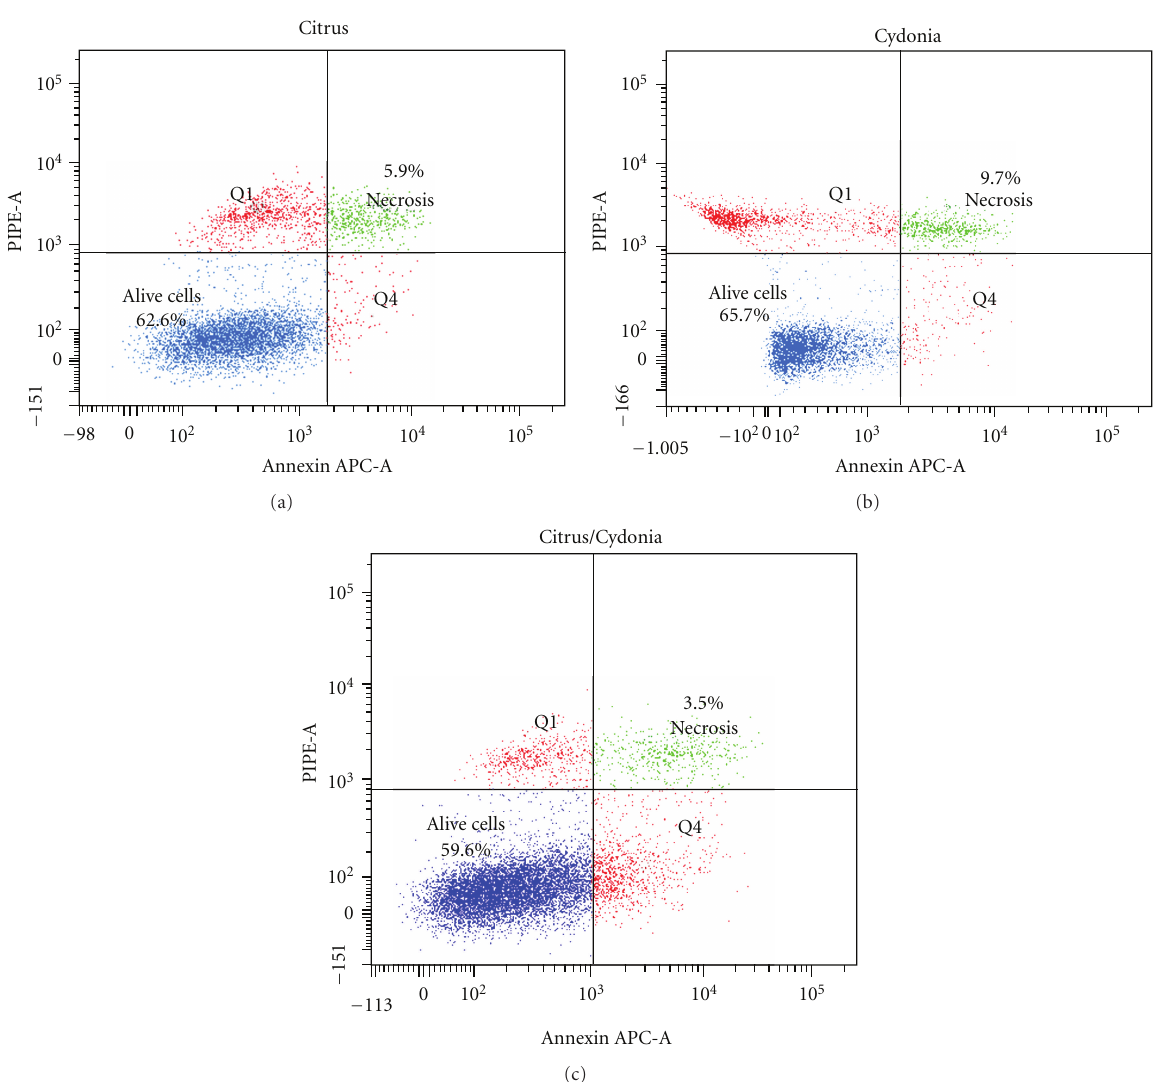
Figure 2: Representative example of a flow cytometric analysis profile of live, necrotic, and apoptotic cells after in vitro culture of human PBMC stimulated in the presence of either Citrus (a) or Cydonia (b) or their combination (c). Citrus (100 μ L/mL), Cydonia (100 μ L/mL), or the combination Citrus/Cydonia (100 μ L/mL) were added to 0 . 5 × 10 6 PBMC in 1mL cultures which were stimulated with grass pollen extract (10mg/mL) for 7 days. Staining was performed with Annexin V-APC and PI and measured on a BD flow